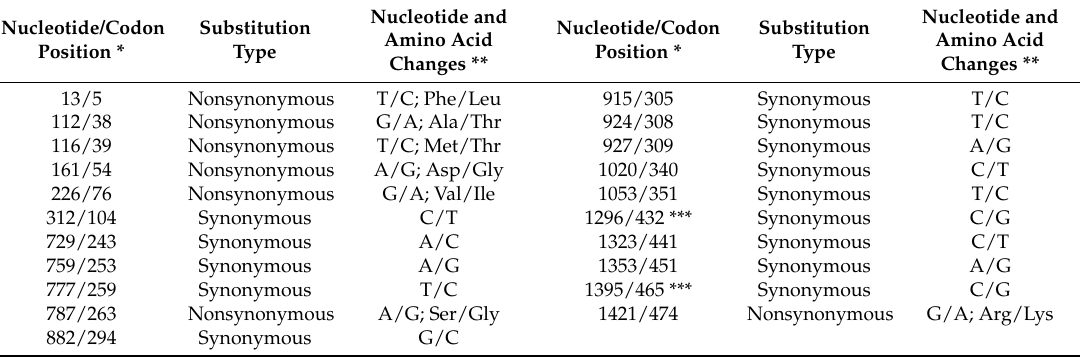
Table 1. Nucleotide and amino acid changes in the CYP51 sequence of wild-type and strain MRHO/IR/75/ER of L. major .